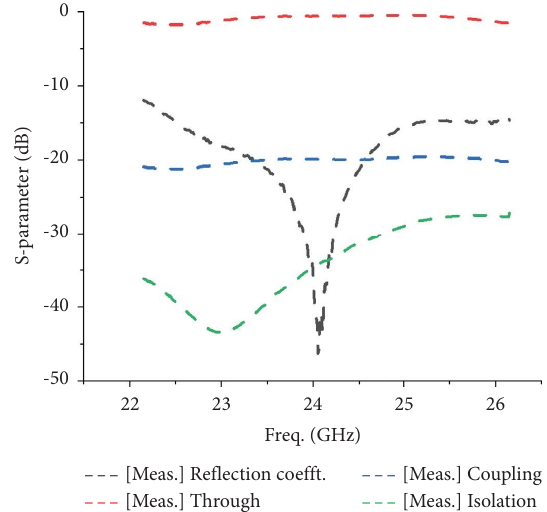
Figure 14: S-parameters of the fabricated 20dB directional coupler.